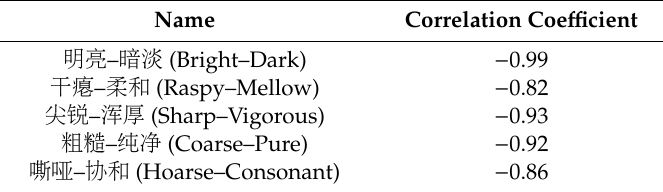
Table 5. An ordinary timbre evaluation term system including five pairs of evaluation terms in their original language (Chinese) and the associated English